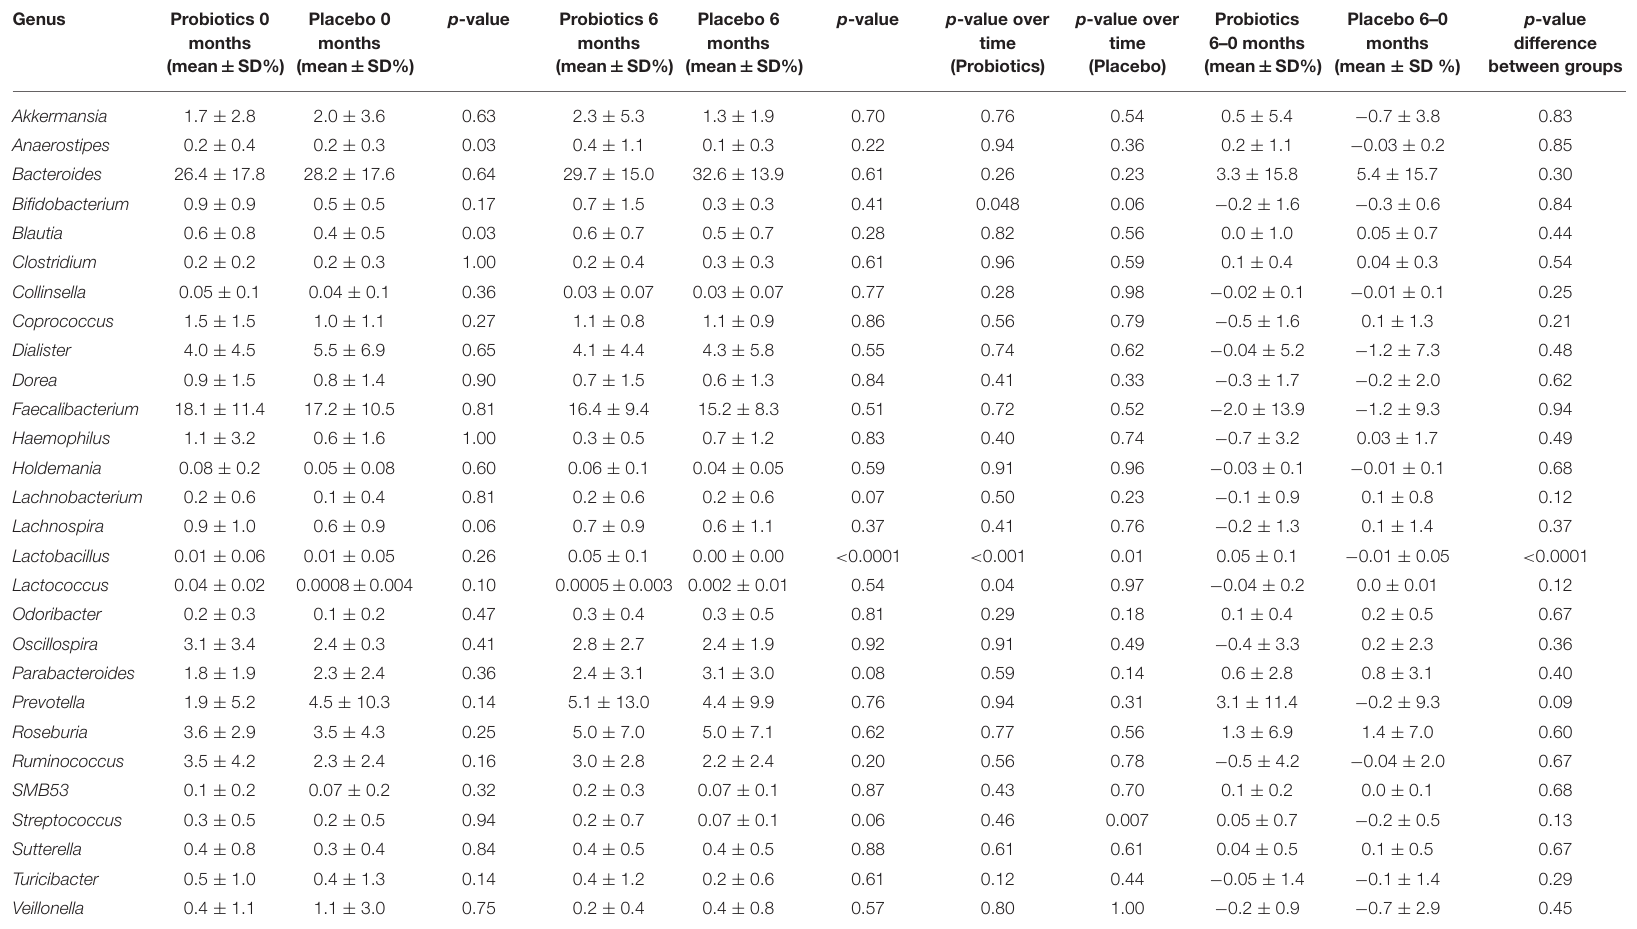
TABLE 3 | Relative abundance of the different genus in study participants either receiving a mixture of L. plantarum HEAL9 and L. paracasei 8700:2 (Probiotics) or maltodextrin (Placebo) at baseline and after 6 months of